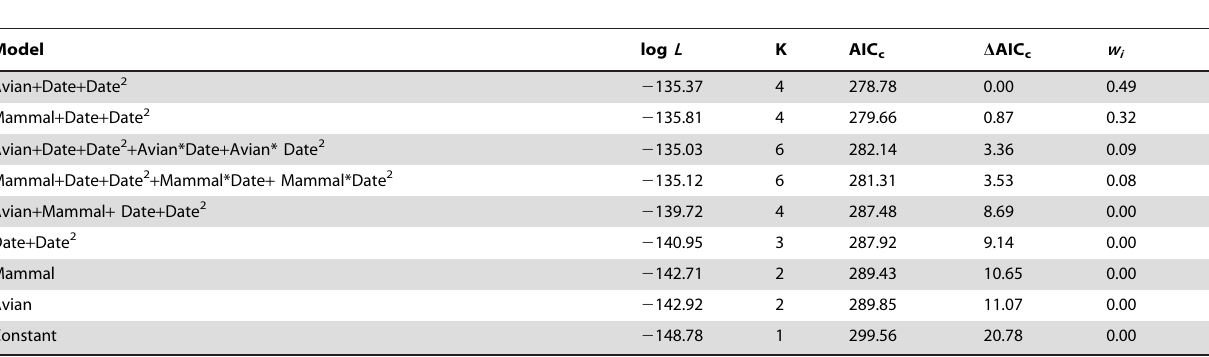
Table 5. Model selection results from models examining the effects of potential avian and mammalian nest predator abundance on the risk of nest predation for Dusky Flycatchers ( n =83) in 2007, Lake Tahoe, California.